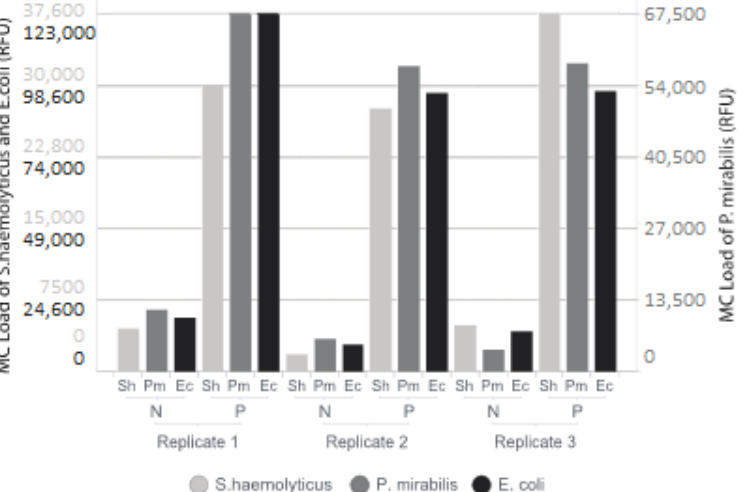
Figure 1. A linear correlation can be seen between Ct values as measured by speci fi c qPCR and MC